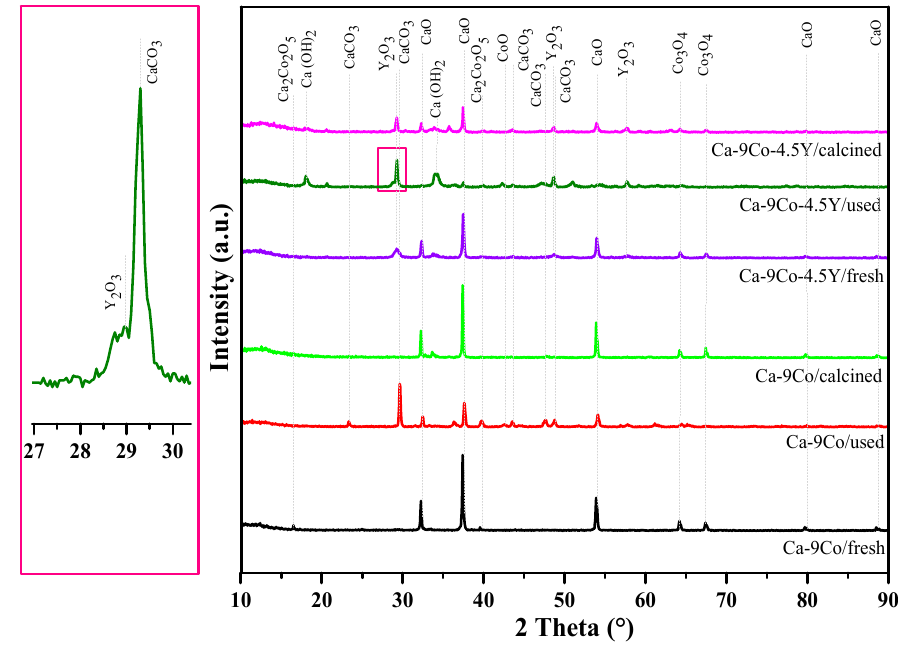
Figure 2. XRD patterns of fresh, used (at 700 °C) and regenerated (calcined) catalyst/sorbents after 16 redox cycles.